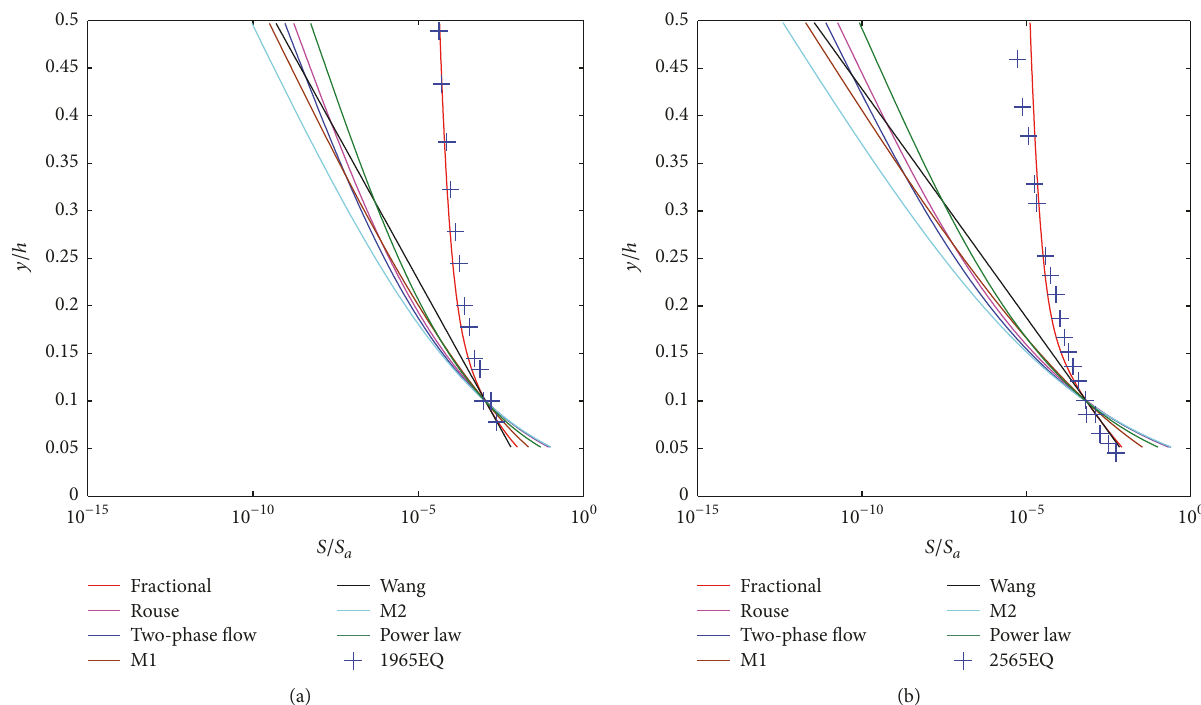
Figure 6: Results of the different models in describing the experimental data of Lyn [26]. (a) 1965EQ ( d = 0.19 mm), the fractional derivative order 𝛼 = 0.93 , and the reference height a = 0.1 h . (b) 2565EQ ( d = 0.24 mm), the fractional derivative order 𝛼 = 0.97 , and the reference height a = 0.1 h .